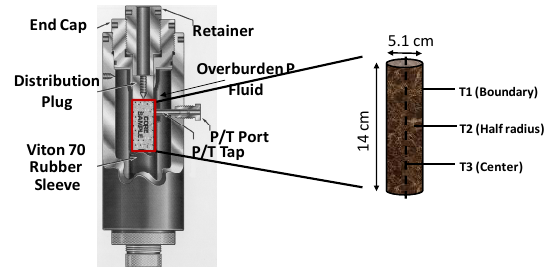
Figure 1. Thermocouple arrangement for Temco core sleeve for hydrate formation/dissociation of Experiments 1–6 with seawater which are shown